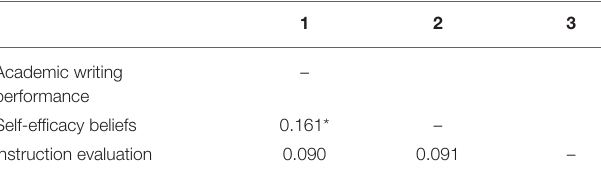
TABLE 9 | Correlations among dependent measures.